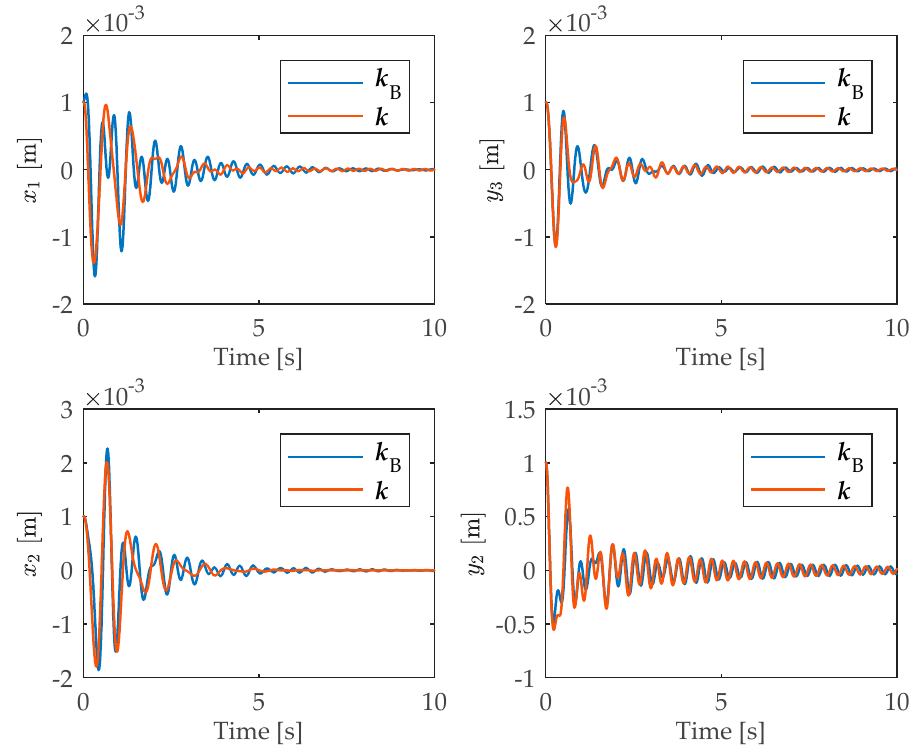
Figure 6. Displacements of the controlled system comparison traditional PPP and the proposed method (test-case 2).